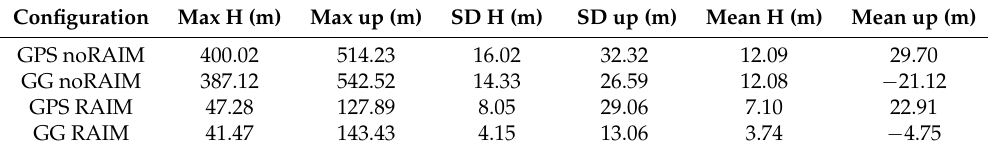
Table 3. Position error statistics considering the different solutions and all epochs.